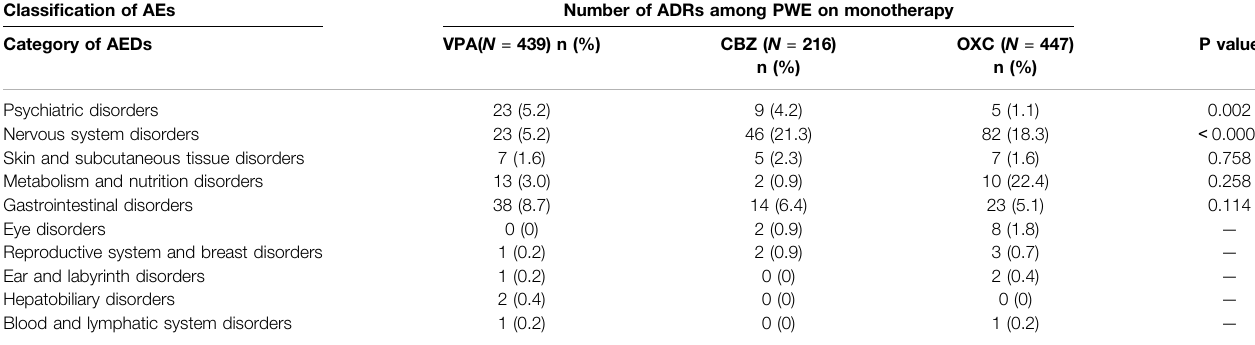
TABLE 4 | Adverse drug effect (AEs) among PWE on monotherapy of